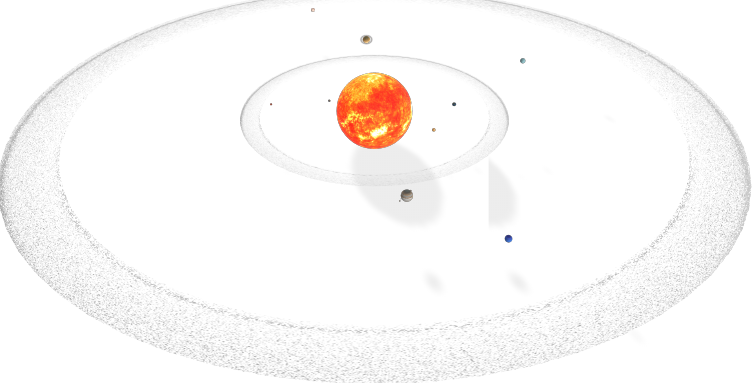
Figure 12. Illustration of the solar system with the main asteroid belt and the Kuiper belt